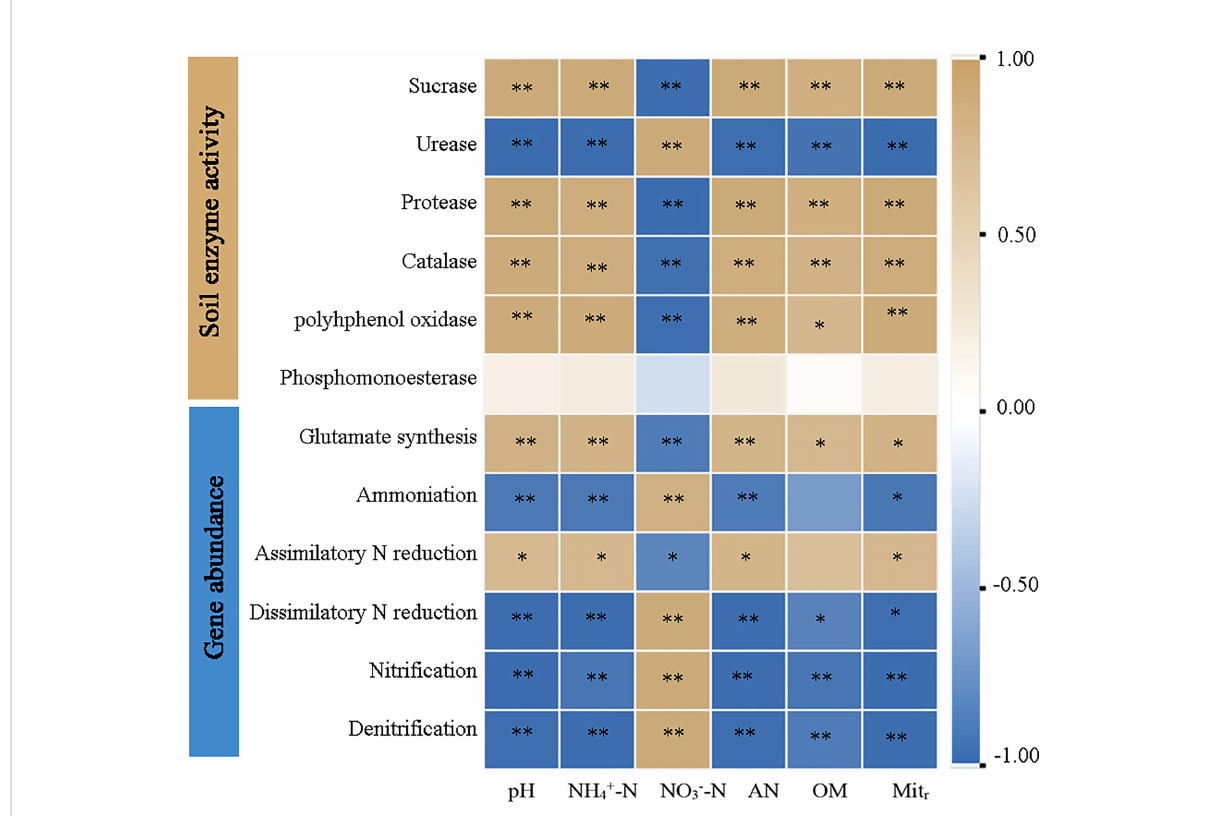
FIGURE 5 Heatmap of pearson correlation analysis of soil physicochemical properties, enzyme activity and functional gene abundance in tea soil with different pH values. NH 4+ -N, ammonium nitrogen content; NO 3 – – N, nitrate nitrogen content; AN, available nitrogen content; OM, organic matter content; Mit r , net nitrogen mineralization rate. * and **, signi fi cant at P ≤ 0.05 and P ≤ 0.01.